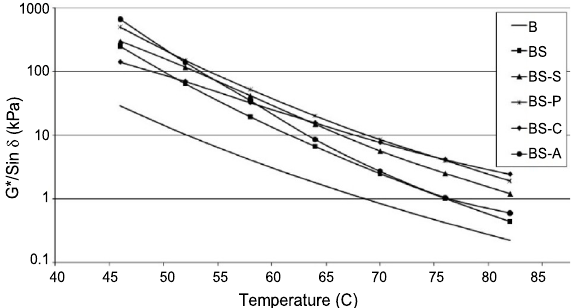
Fig. 8. G*/Sin δ for bitumen binder aged with RTFO at 1.59 Hz